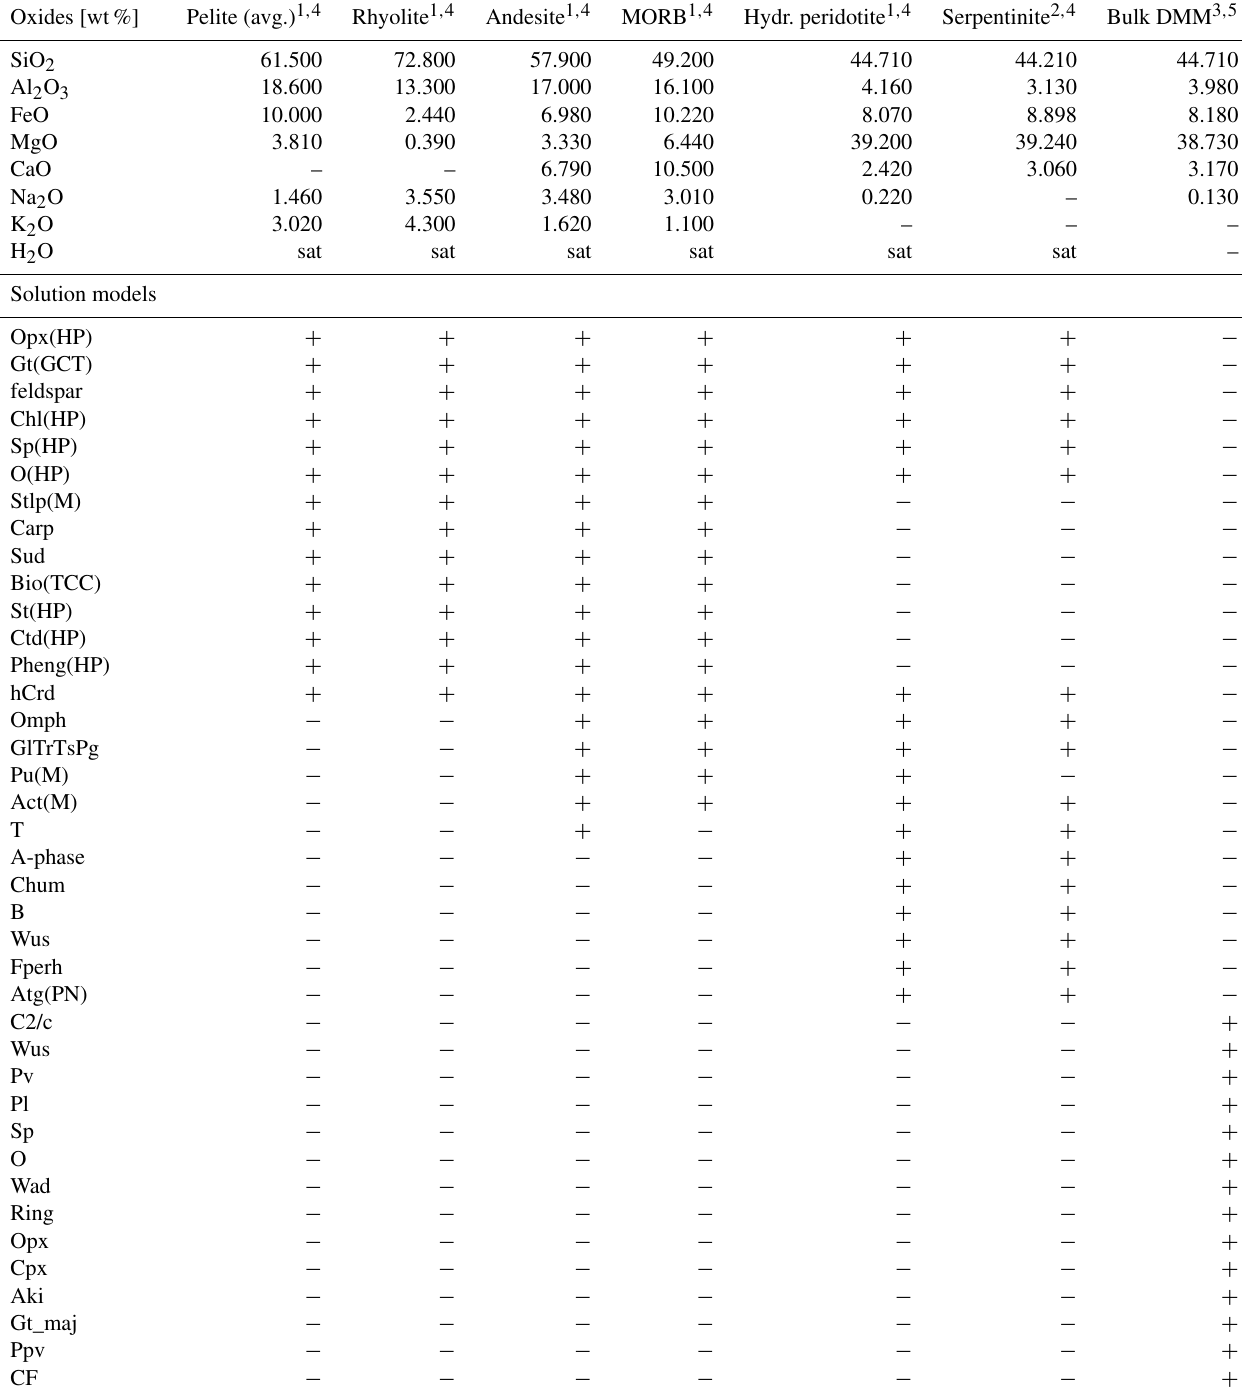
Table 2. Bulk rock composition for phase equilibrium